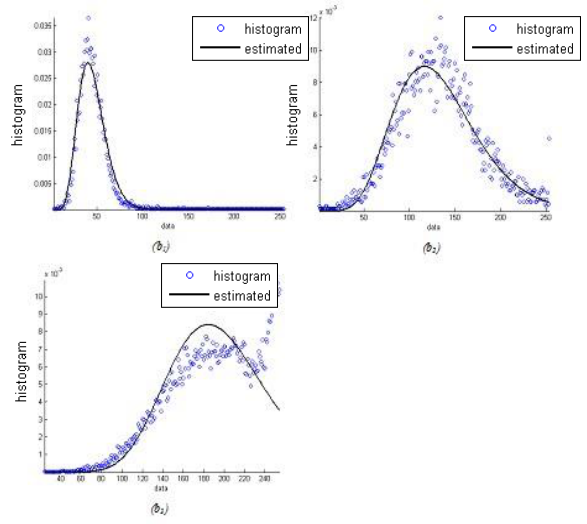
Figure 4. Histogram and Gamma distribution with estimated parameters of segmented regions (b 1 , b 2 , b 3 ) with N P =800 for SAR intensity image shown in Figure